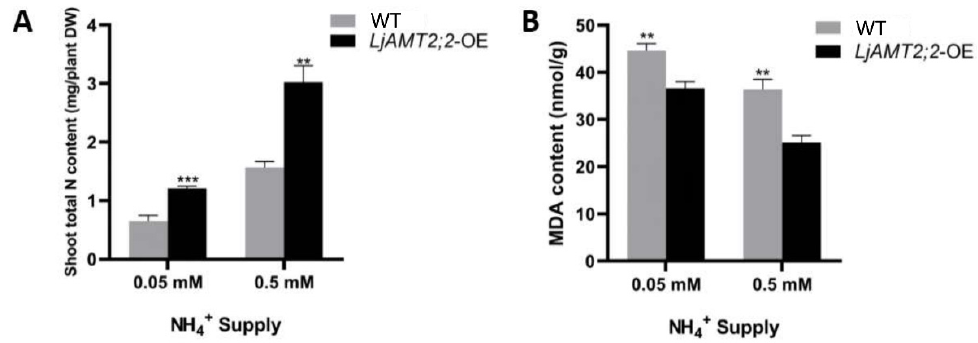
Figure 7. Comparison of physiological indices between LjAMT2;2 -OE and wild-type plants. ( A ) Total nitrogen content. ( B ) MDA content. Data are means ± standard error (SE; n ≥ 3 biological replicates; ** p ≤ 0.01, *** p ≤ 0.001).